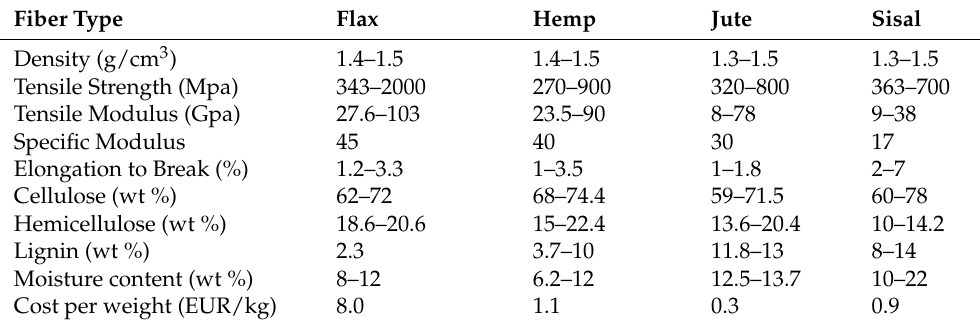
Table 1. Property comparison of the commonly used fibers for biocomposites, created by authors based on